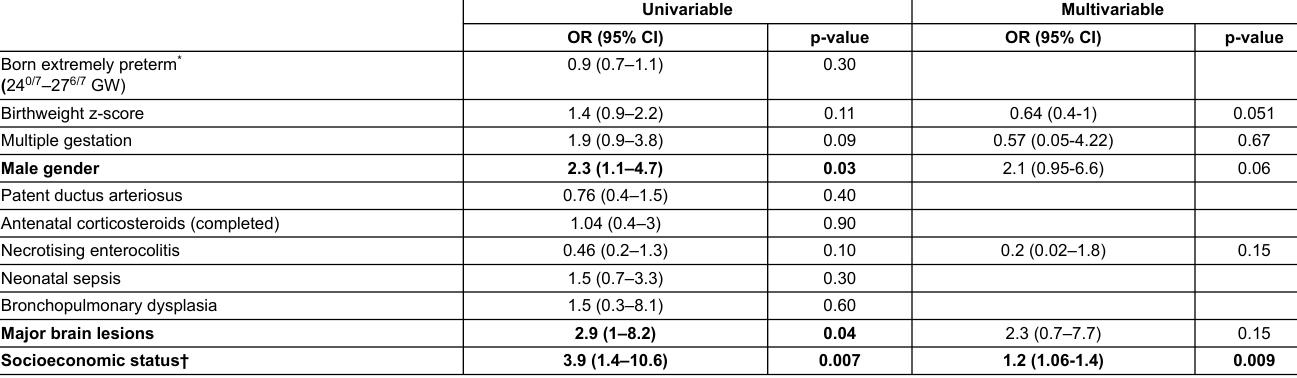
Table 5: Factors associated with an impaired cognitive outcome defined as a MPC score <−1SD at early school